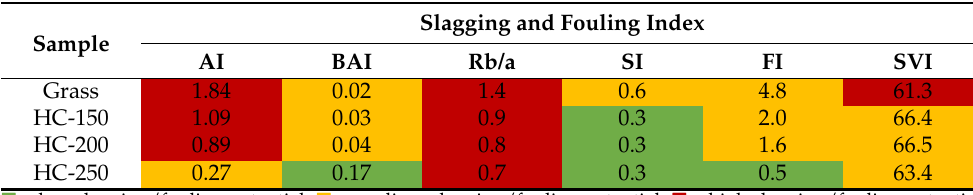
Table 4. Predicted slagging and fouling indices for grass and hydrochars.